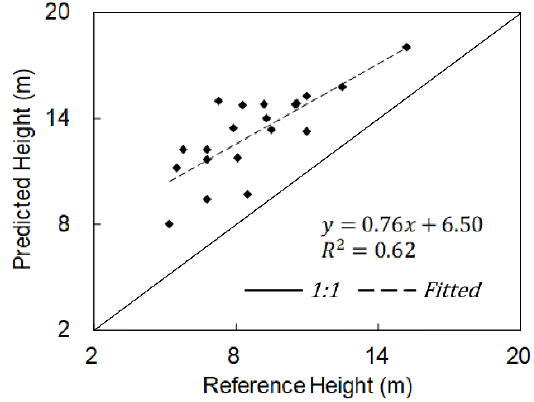
Figure 15. Independent validation of the predicted forest canopy height.